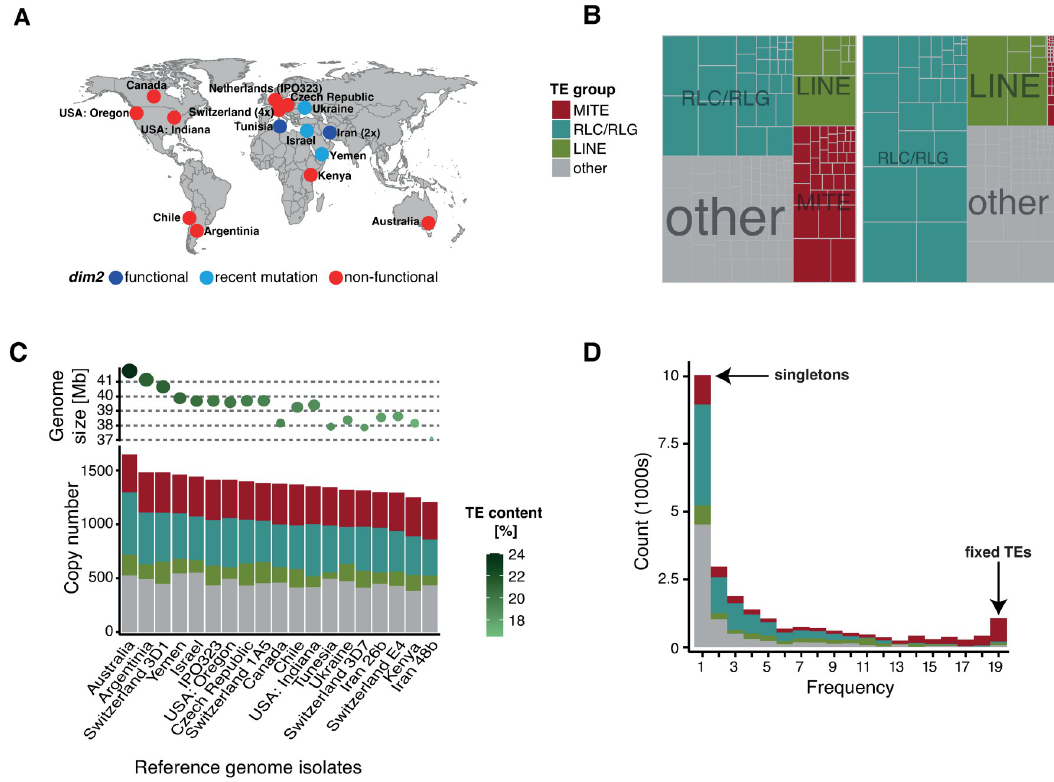
Fig 1. Transposable element (TE) distribution in 19 telomere-to-telomere genomes of Zymoseptoria tritici : (A) Origin of reference genome isolates originally used for the Z . tritici pangenome reported by Badet et al [52]. The color indicates the status of the dim2 gene with an important influence on RIP. Data from Mo¨ller et al [62]: dark blue = present and functional, bright blue = recently mutated, red = non-functional. Map created with ggmap version 3.0.0 [73]. Map data from OpenStreetMap: https:// www.openstreetmap.org/copyright. (B) Genome size and TE copy number per isolate. Circle sizes indicate the genome size, the green shade indicates the TE content. The colors indicate MITEs (miniature inverted repeat transposable elements, small non- autonomous DNA transposons corresponding to several TE superfamilies), RLC and RLG (two superfamilies belonging to LTR) and LINE. (C) Copy numbers of TEs (left) and total length (right) in all 19 genomes. Smaller boxes correspond to TE families. (D) Allele frequency distribution of TEs at orthologous loci among genomes. TEs were defined as orthologous if they were located between the same set of orthologous genes.